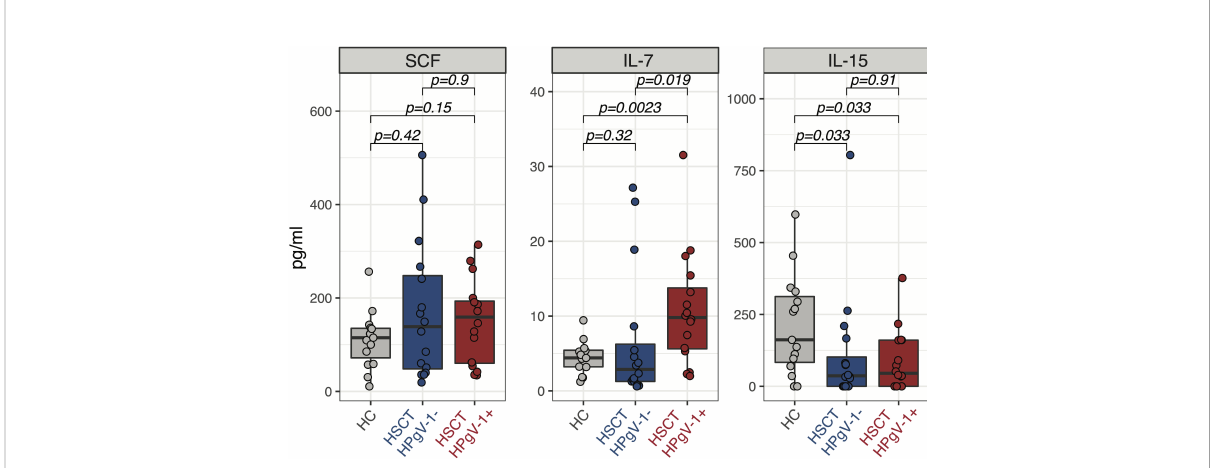
FIGURE 4 Levels of homeostatic cytokines in HPgV-1-viremic and non-viremic HSCT recipients. Levels of SCF (left panel), IL-7 (middle panel) and IL-15 (right panel) in plasma from HPgV-1-viremic (HPgV+; red fi lled symbols) and HPgV-1-non viremic (HPgV-; blue fi lled symbols) HSCT recipients at day 30 after transplantation. Results in the two patient groups were compared using a nonparametric Mann-Whitney U test.